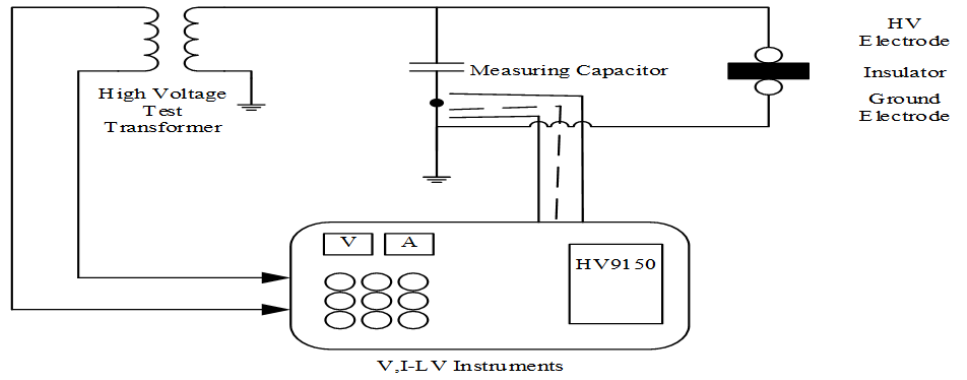
Figure 2. Circuit diagram of Experimental